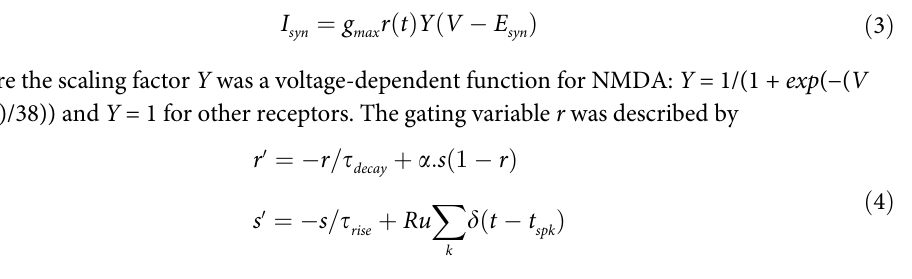
Short-term synaptic plasticity (STP) was modeled with a simple phenomenological model that describes the kinetics of such plasticity. It treats short-term depression and facilitation as two independent variables, R and u , respectively [40, 41] as